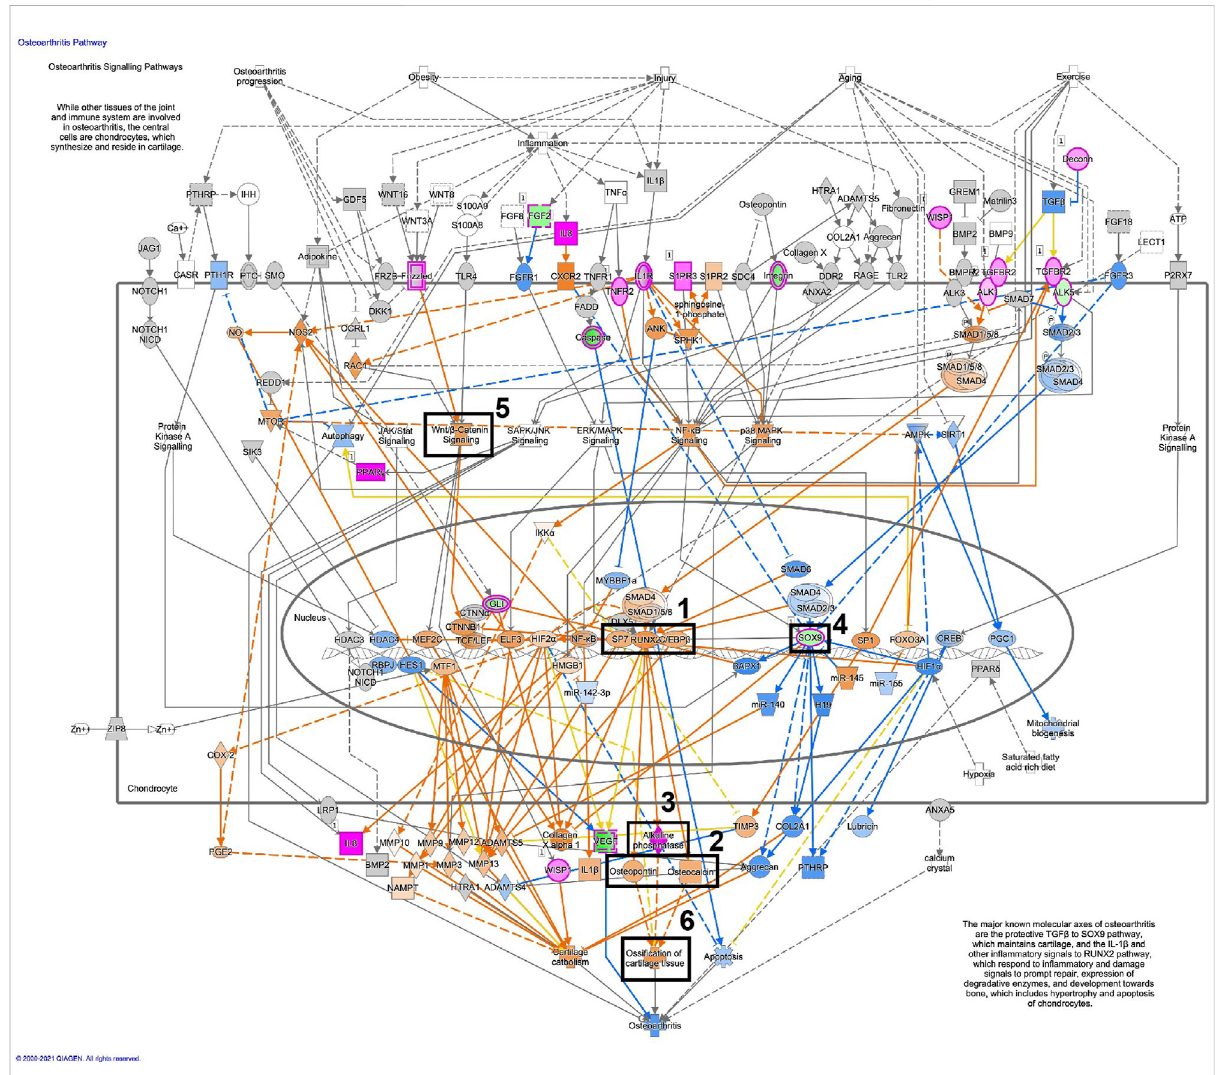
FIGURE 12 Osteoarthritis pathway is activated in osteoblastic differentiated MSCs. Detailed illustration of the osteoarthritis pathway in osteoblastic differentiated MSCs, based on the RNA-seq data. The most essential osteoblastic markers and processes have been highlighted in fi ve boxes (1 – 5). Box 1 (SP7, RUNX2, CEBPB), Box 2 (SPP1/osteopontin, BGLAP/osteocalcin), Box 3 (ALP/alkaline phosphatase), Box 4 (Sox9), Box 5 (Wnt/ β -catenin signaling),Box6(Ossi fi cationofcartilagetissue).Forthepathwaymap,geneswithanp_adj. < 0.01wereselectedfromtheRNA-seqdata.Genes colored in pink are up-regulated, and genes colored in green are down-regulated. Genes colored in orange are predicted to be up-regulated, and genes colored in blue are predicted to be down-regulated, based on measured expression values from the